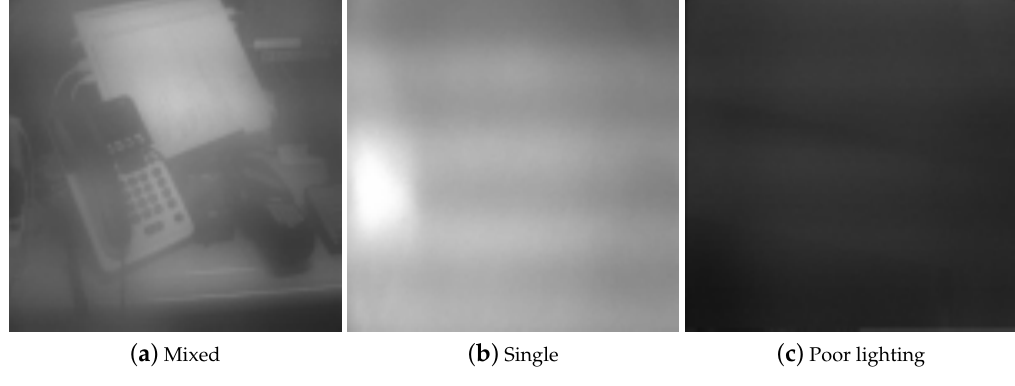
Figure 10. Three types of images.